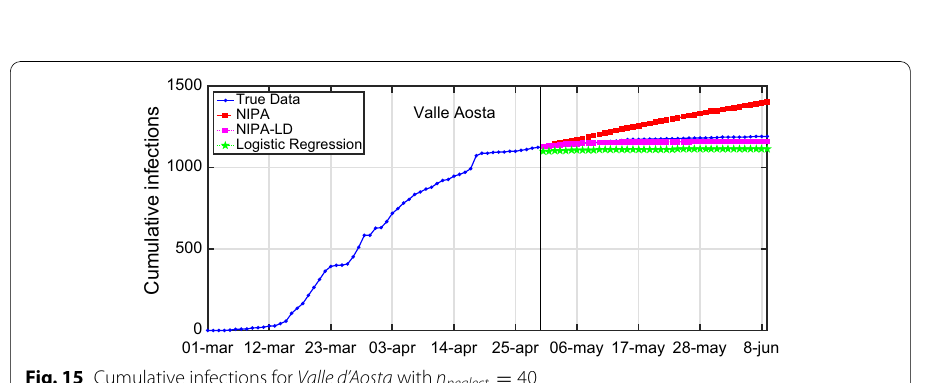
Fig. 15 Cumulative infections for Valle d’Aosta with n neglect = 40